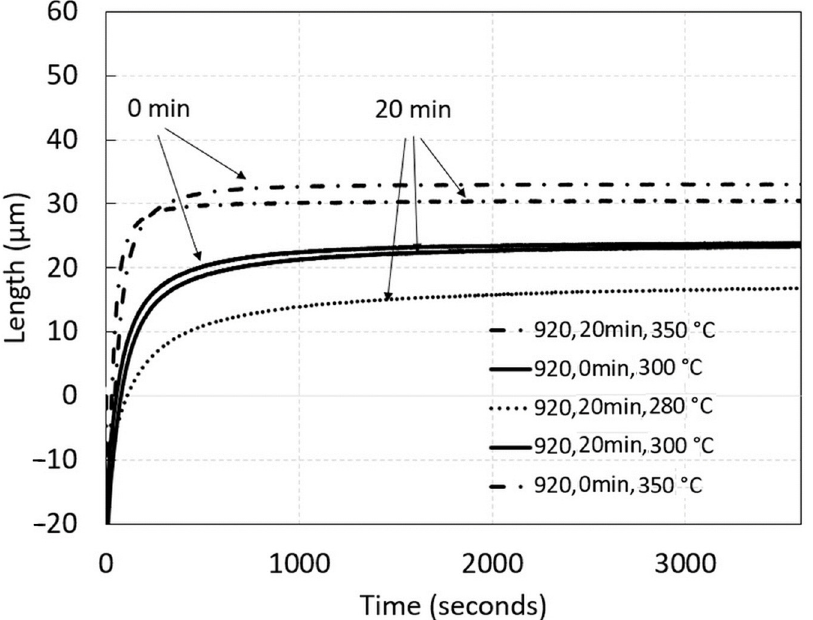
Figure 6. A detail of isothermal transformation kinetics with time shifts not including the incubation time for bainite start.